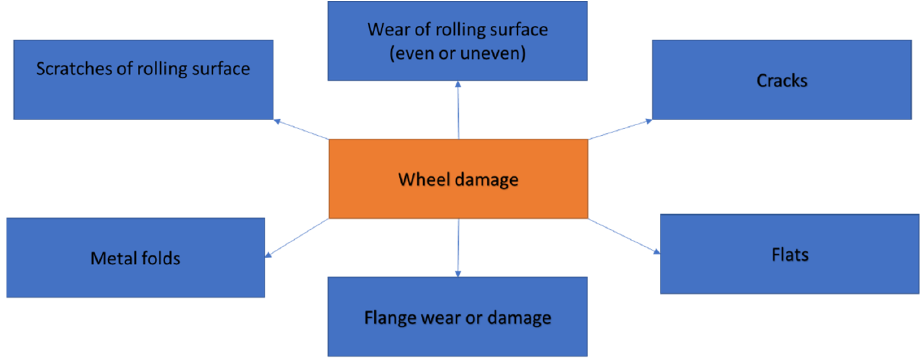
Figure 2. Main nature of damage of wheel rolling surface. Flange damage. The wheel flange prevents the wheel from derailing. A wheel is considered damaged when its flange is critically thinned (up to 25 mm). Metal folds. Metal folds occur in the presence of thermomechanical damage [24]. Intense plastic deformation of the metal occurs due to sudden braking, short ‐ term wheel slip, wheel jumping, or sudden heating of the wheel metal, and then sudden cooling [25].